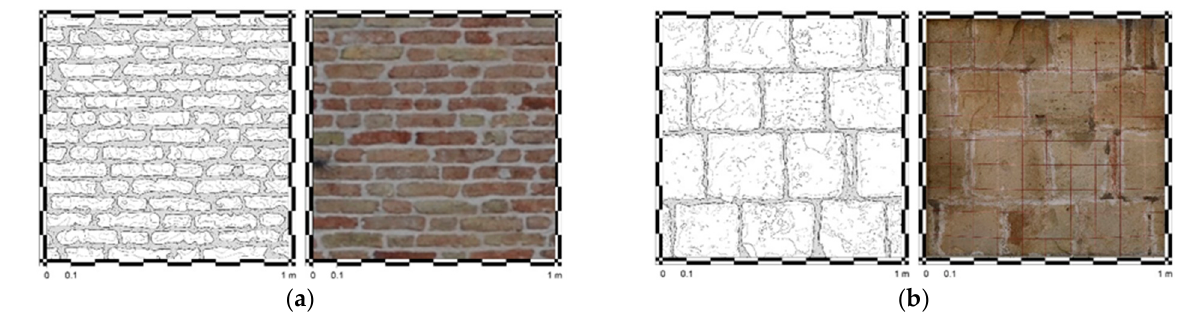
Figure 9. ( a ) Masonry sample of upper part North front, bricks and mortar and ( b ) masonry sample of lower part North front, sandstone and mortar.